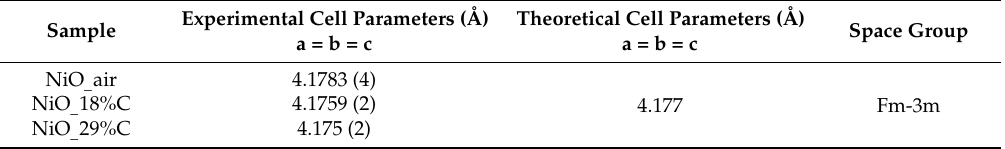
Table 2. Theoretical and experimental cell parameters for NiO_air, NiO_18%C, and NiO_29%C